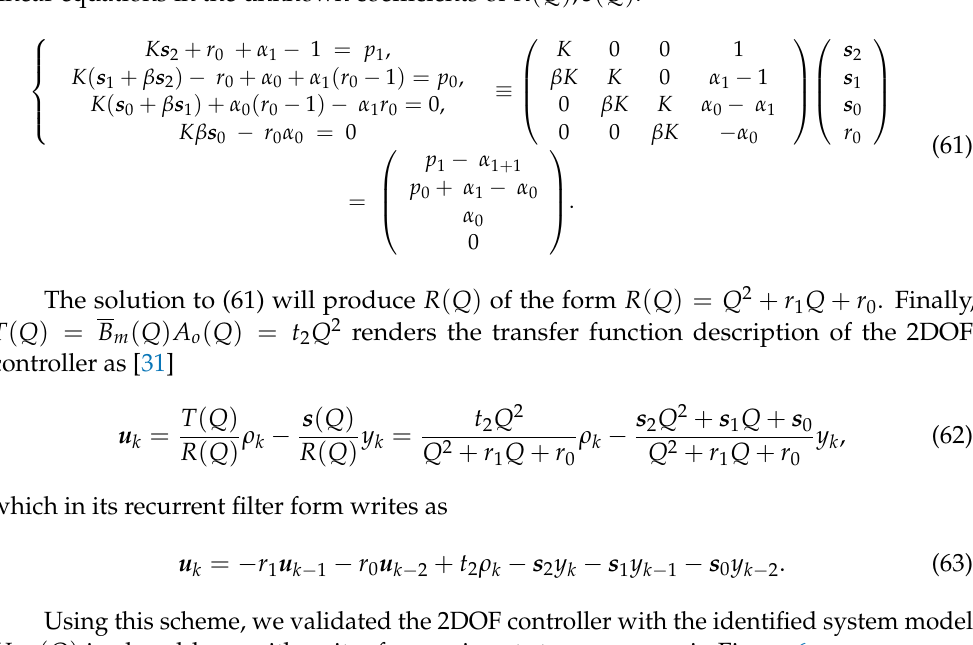
Figure 5. The step response of 𝐻 𝑃𝐶 (𝑞) [31].